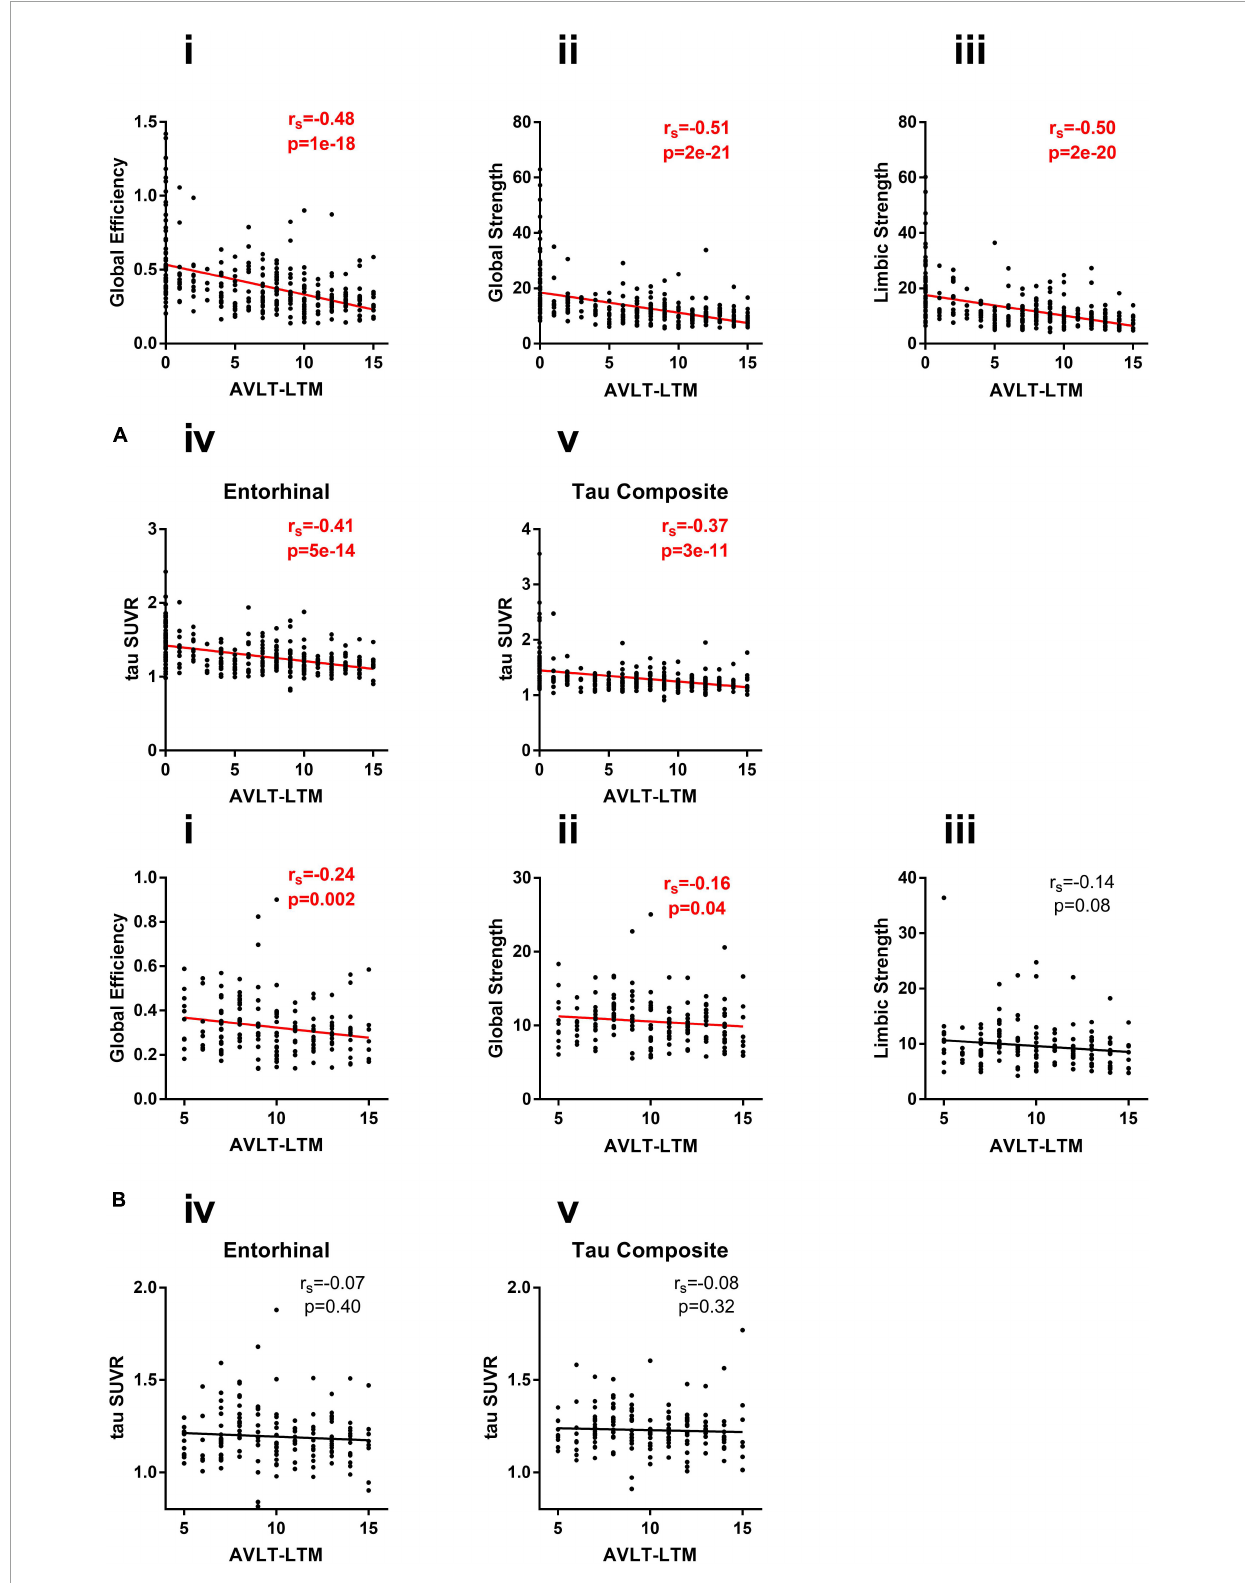
FIGURE5 (A) Correlation of network measures (i) global efficiency, (ii) global strength, and (iii) limbic strength, and regional measures (iv) entorhinal SUVR, and (v) tau composite SUVR with AVLT-LTM in all subjects (CU/MCI/AD). (B) Correlation of network measures (i) global efficiency, (ii) global strength, and (iii) limbic strength and regional measures (iv) entorhinal SUVR, and (v) tau composite SUVR with AVLT-LTM in CU